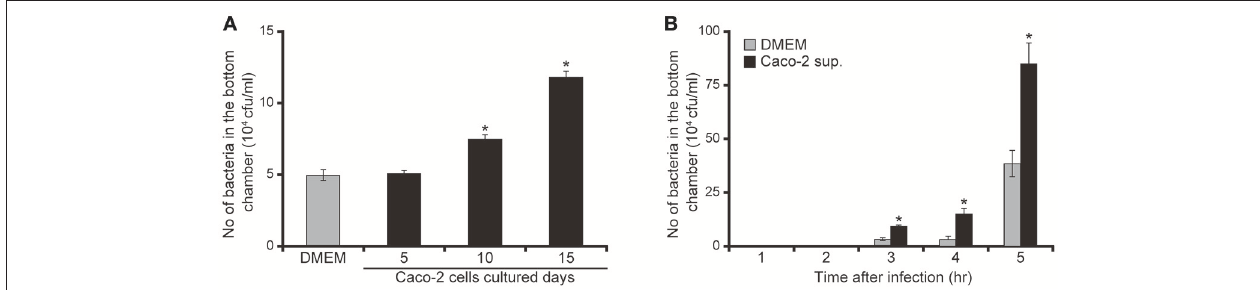
FIGURE 1 | Caco-2 cell supernatant facilitates penetration of the P. aeruginosa PAO1 strain through the mucin layer. (A) The bottom chambers of Transwell cells were filled with Caco-2 cell supernatant (collected after 5, 10, and 15 days of culture) or with Dulbecco’s modified Eagle medium (DMEM; control). The P. aeruginosa PAO1 strain was added to the top chamber. After 3h, the numbers of bacteria in the bottom chambers were counted. Error bars indicate standard error ( n = 3). * P < 0.05 compared with DMEM. (B) Caco-2 cell supernatant after 15 days of culture (Caco-2 sup.) or DMEM (control) filled the bottom chamber of Transwell cells. After the P. aeruginosa PAO1 strain was added, the numbers of bacteria in the bottom chambers were counted at 3, 4, and 5 h. Error bars indicate standard error ( n = 3). * P < 0.05 compared with DMEM at the same incubation time.